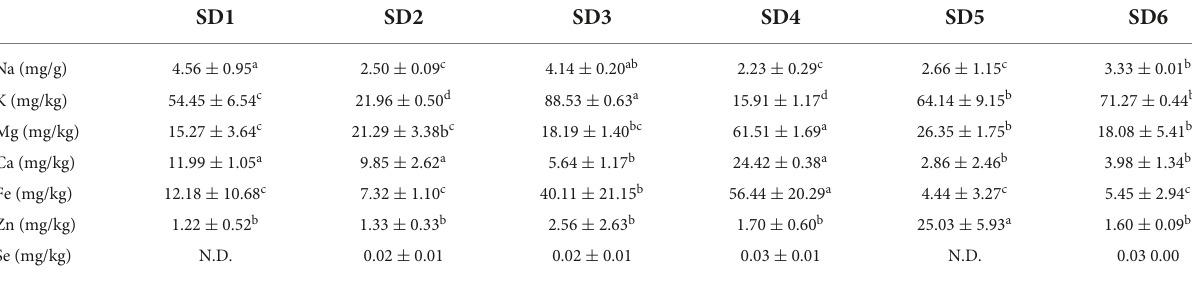
TABLE 7 Comparison of the mineral content in different sweet salad